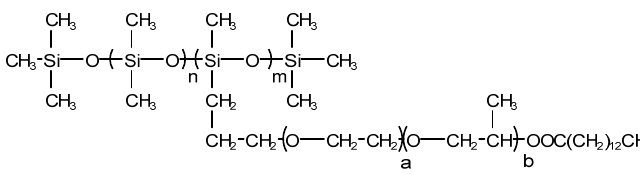
Figure 6. Structure of poly (ether-ester)-modified silicone.